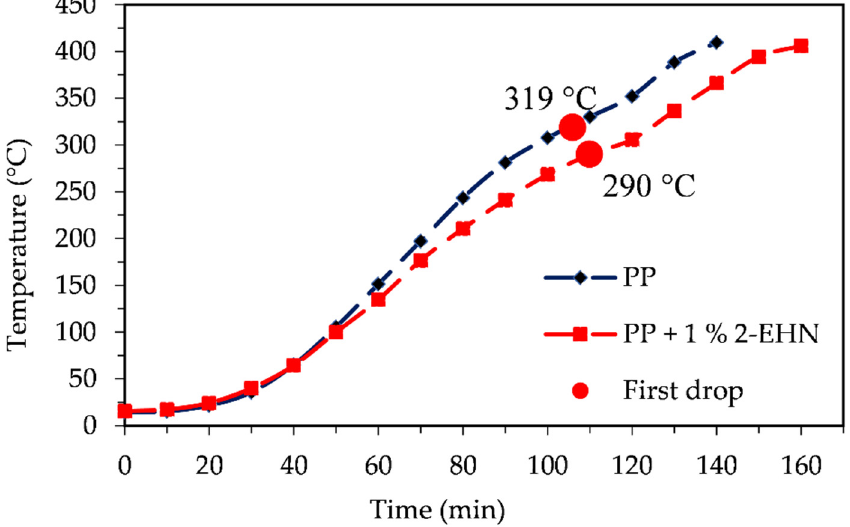
Figure 1. Temperature profiles of the pyrolysis process for PP (black), PP + 1% 2-EHN (red), first drops (red dot).